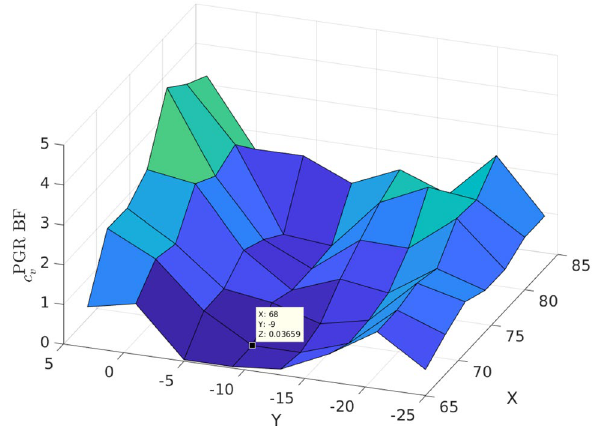
Fig. 19 c PGR v index for each (X,Y) cube’s position, considering 3-dimensional translations only